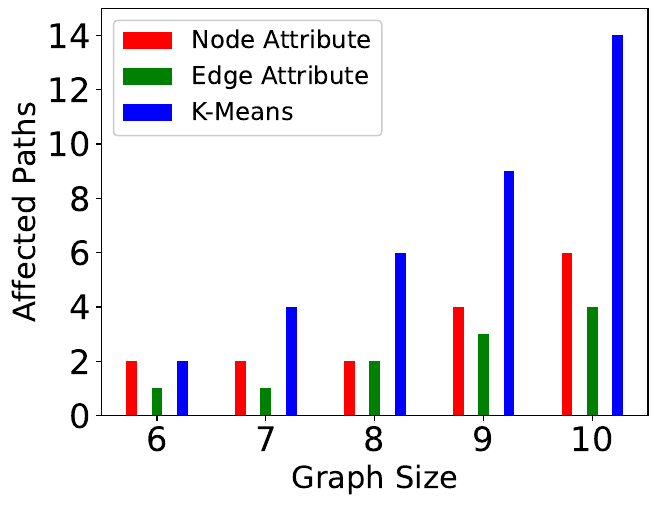
Figure 11. Paths computed in Pg-TSP.